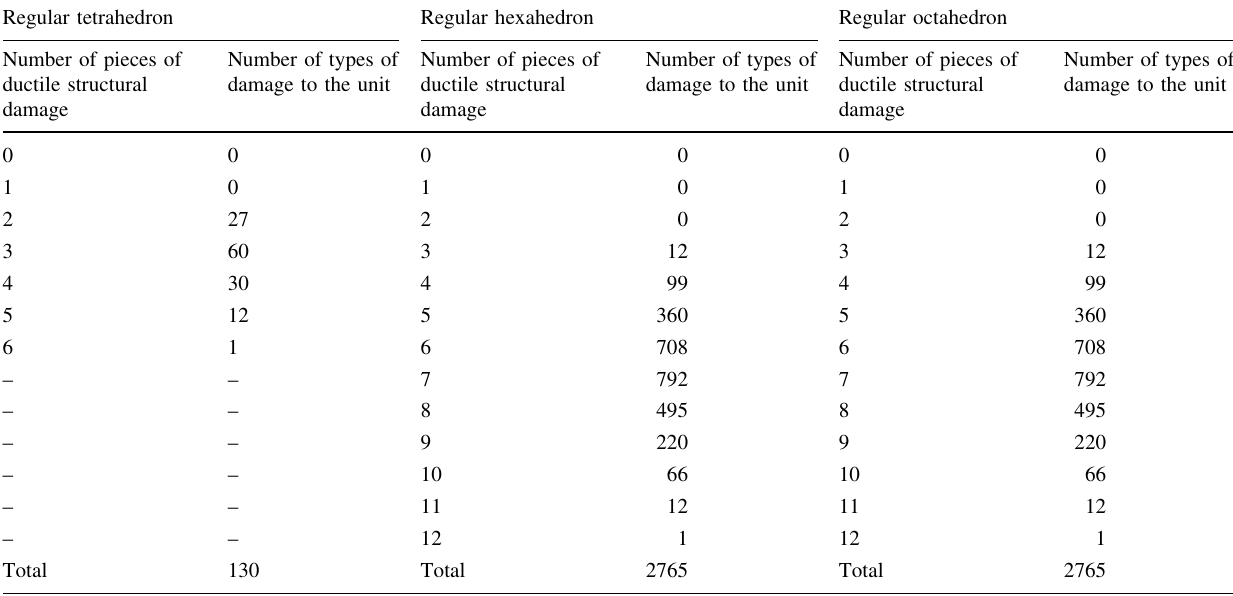
Table 3 Failure types of pore-centered microstructural units in weakly cemented sandstone Regular tetrahedron